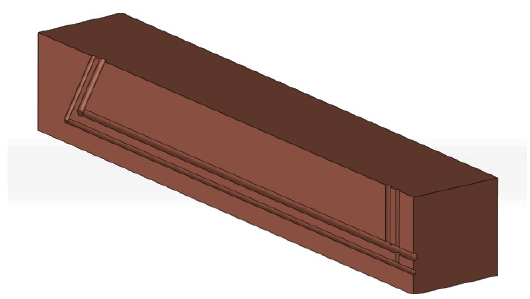
Figure 19. Model showing the deep drilling of the longitudinal cooling channels.